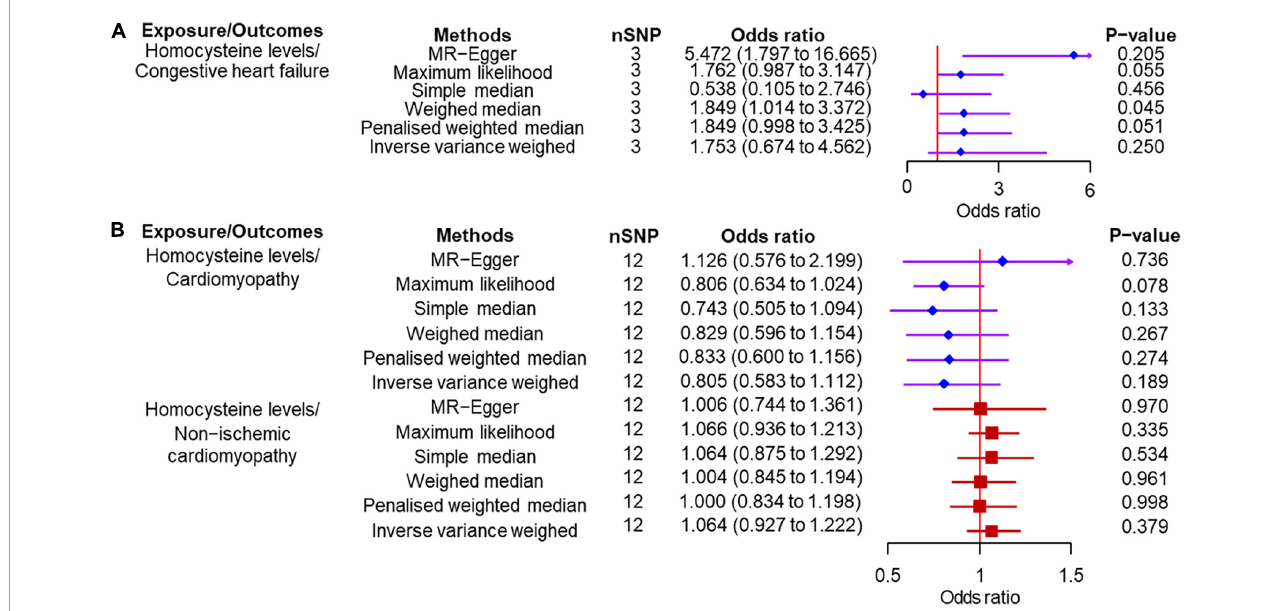
FIGURE3 Two-sample Mendelian randomization of plasma homocysteine levels and the risk of diseases. (A) Congestive heart failure. (B) Cardiomyopathy and non-ischemic cardiomyopathy. CI, confidence interval; SNP, single nucleotide